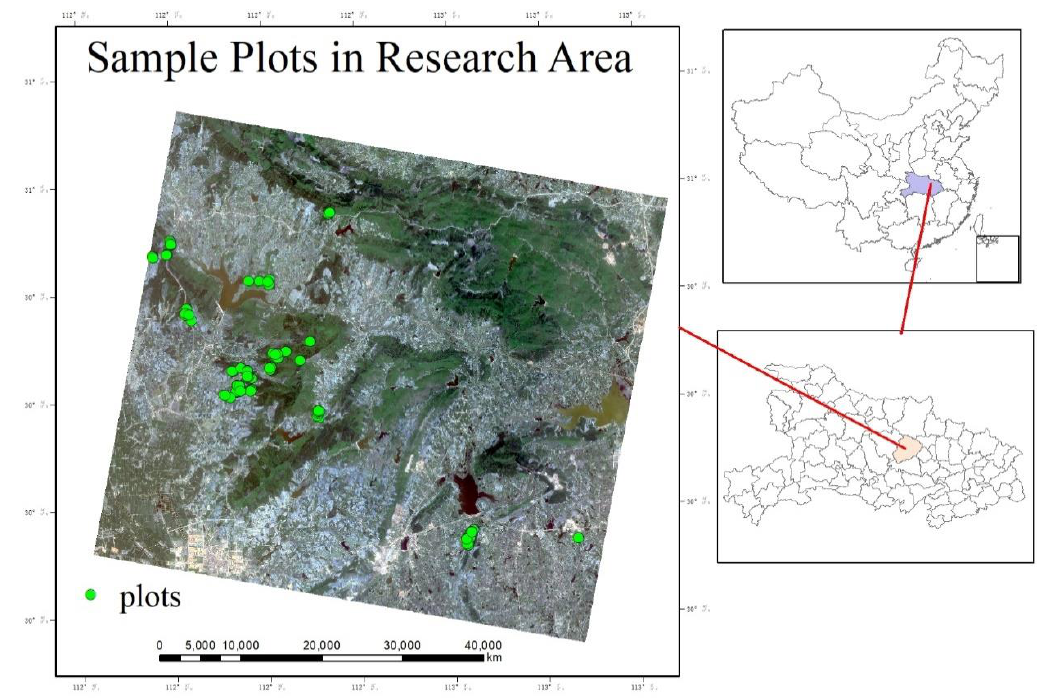
Figure 1. Location of the research area and the filed plots identified in GF2 imagery.